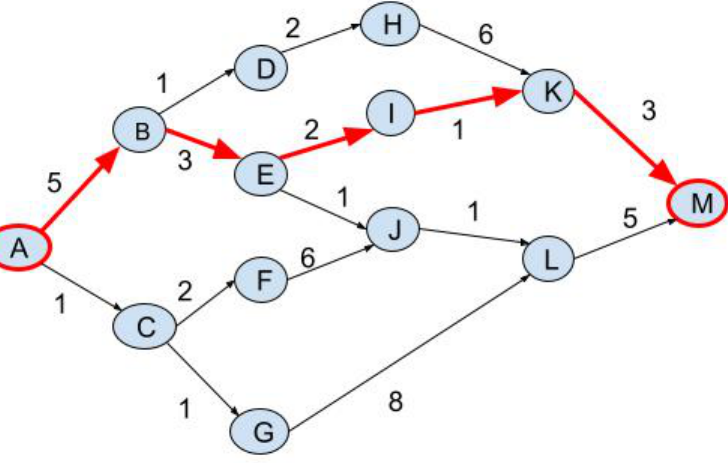
Figure 1. Example on shortest path in road network